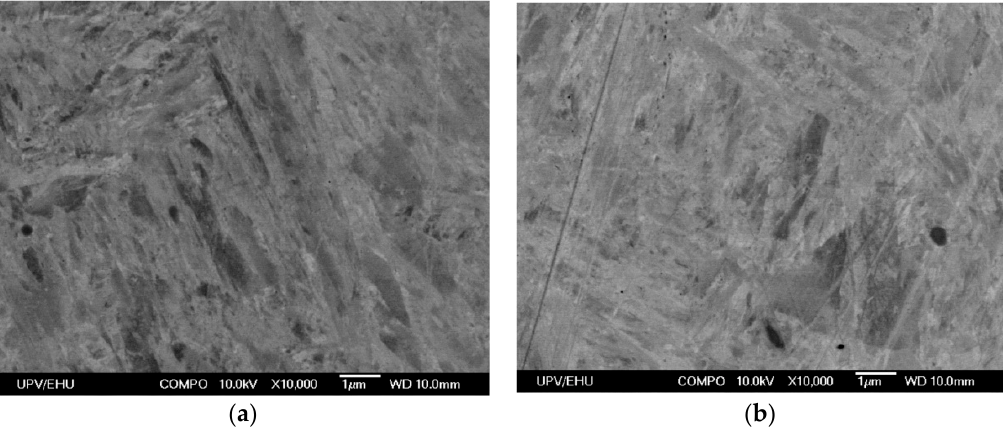
Figure 4. SEM images of the Sample 1 ( a ) and Sample 2 ( b ) microstructures. The martensitic structure